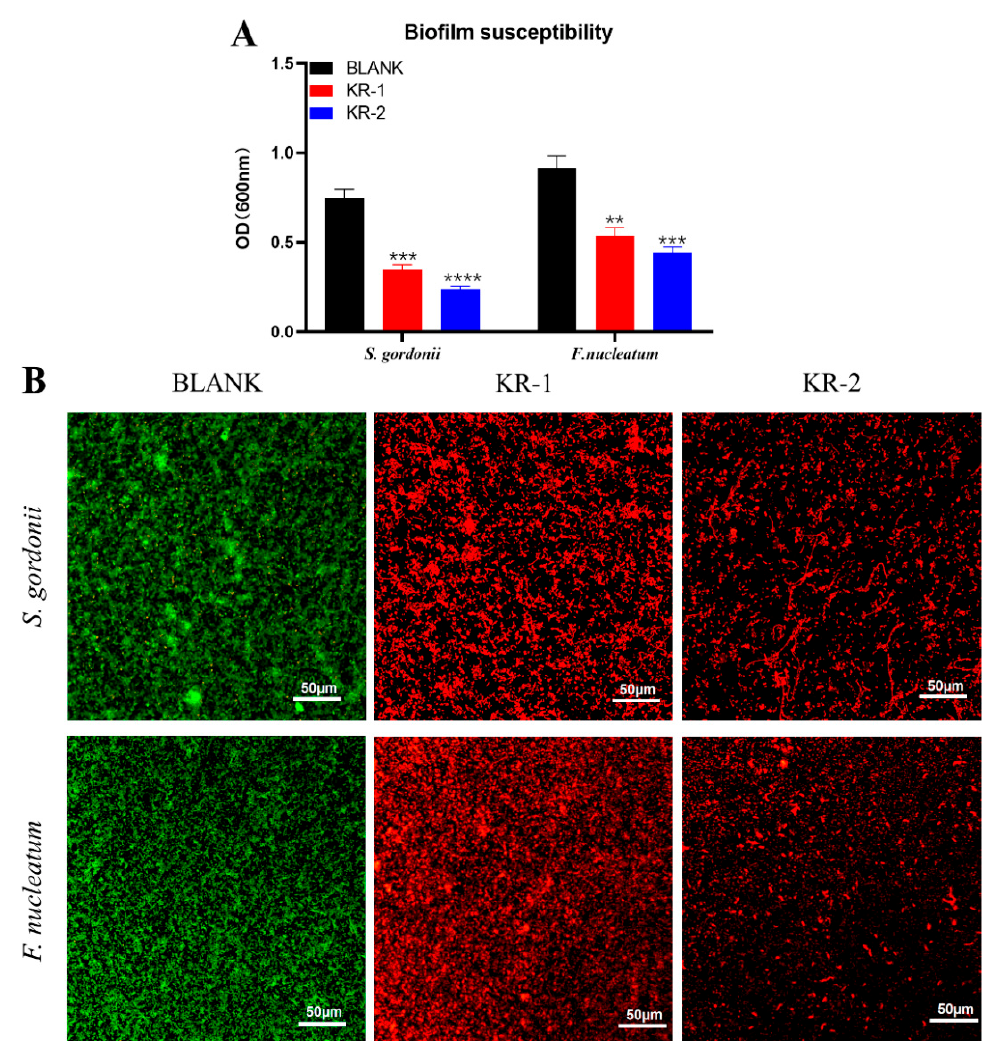
Figure 2. Antibacterial effects of KR − 1 and KR − 2 on S. gordonii and F. nucleatum , respectively. Crystal violet-stained OD values ( A ) and AO/EB-stained confocal laser (CLSM) images ( B ) of bacteria treated with different antimicrobial peptides for 24 h ( S. gordonii )/48 h ( F. nucleatumi ). Note: green represents live bacteria, red represents dead bacteria; data are presented as mean ± standard deviation ( n = 3). * Indicates statistical significance between the BLANK group and other groups. (** p < 0.01, *** p < 0.001, and **** p < 0.0001, ANOVA).